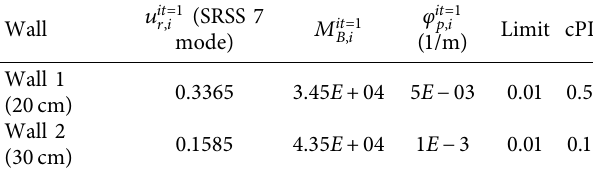
Table 11: Curvature and walls cPI